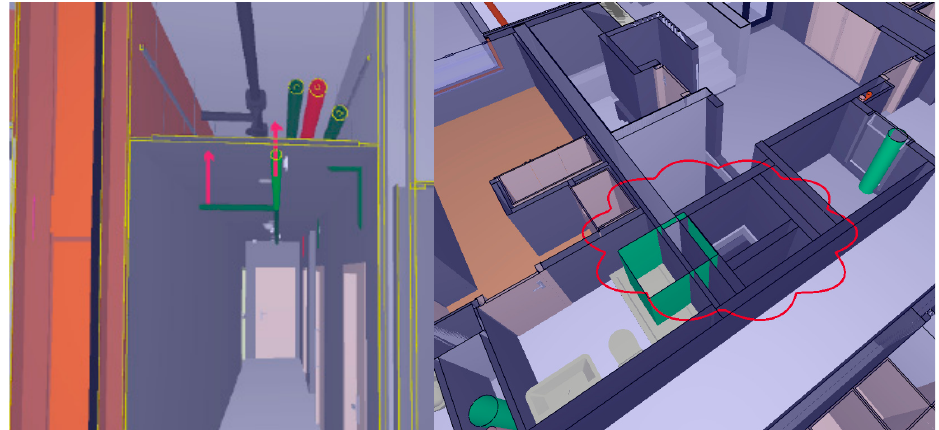
Figure 8. Virtual representation of modeling problems, presenting a plumbing pipeline in a lower position than defined ( left ) and a ventilation duct out of position ( right ). BIM Model.